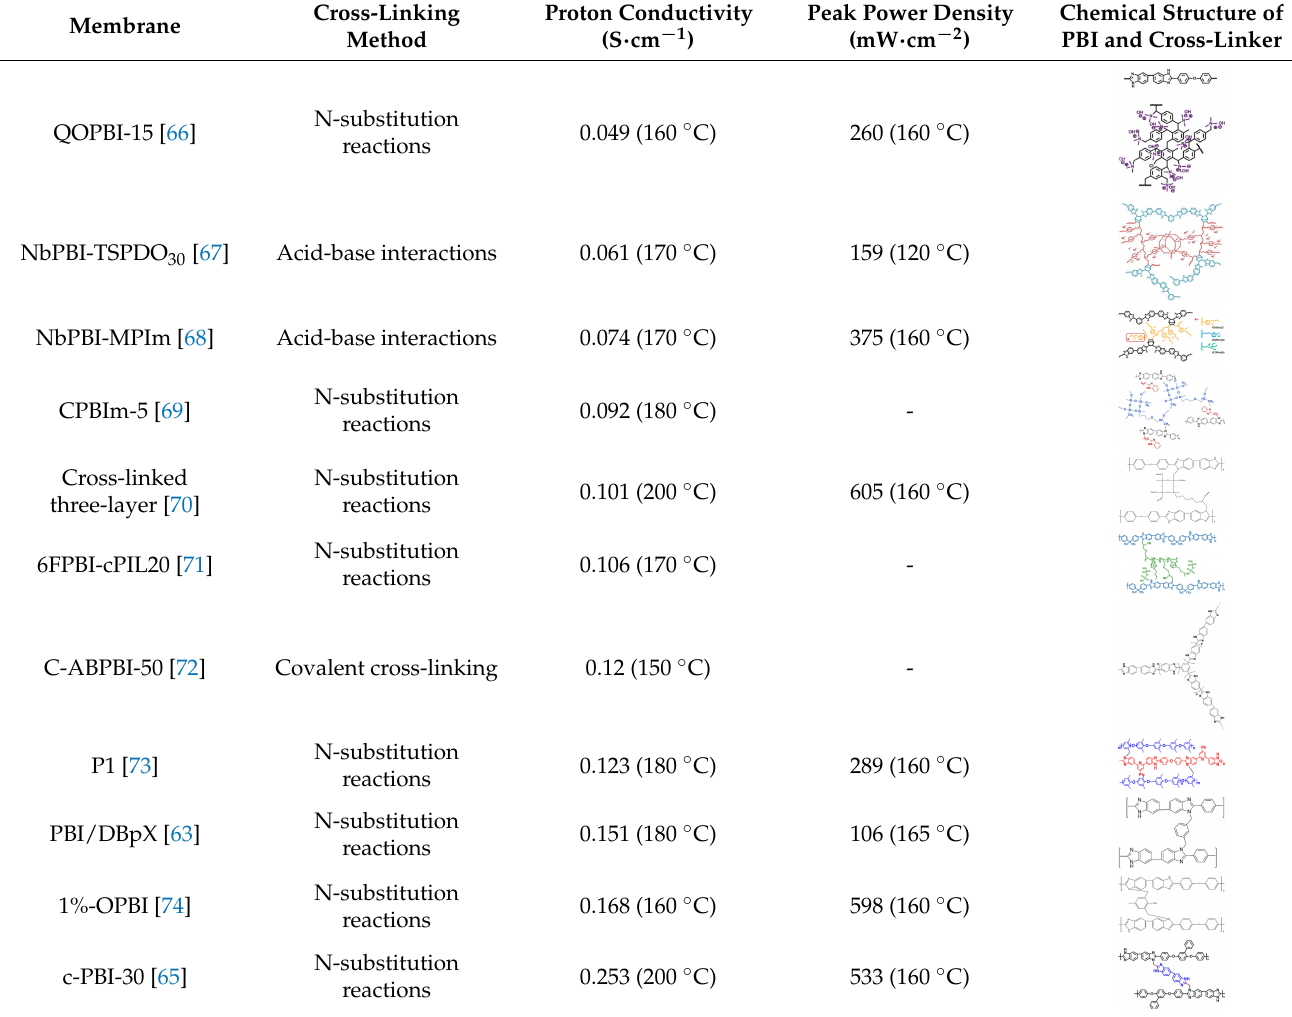
Table 2. Some cross-linked polybenzimidazole